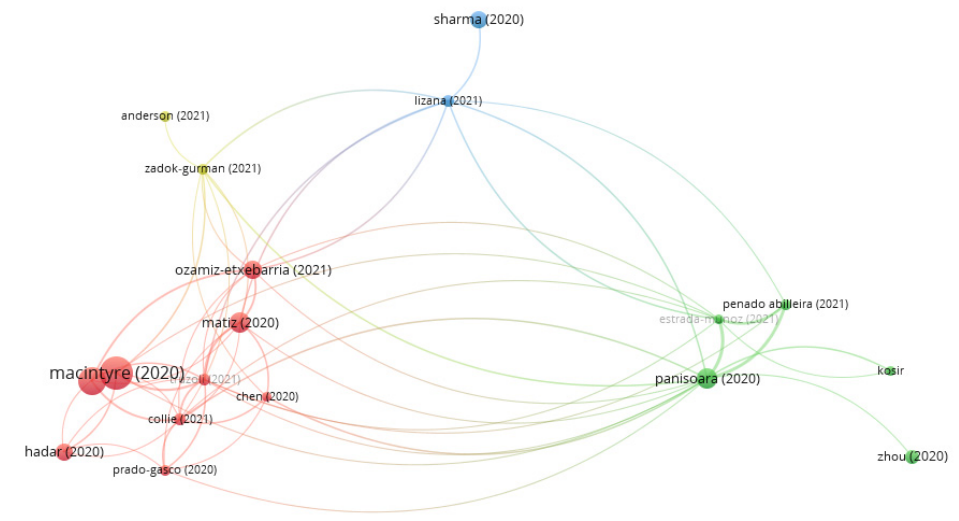
Figure 11. Bibliographic coupling analysis of documents ( ≥ 6 citations for publications). papers in the cluster, citations and leading